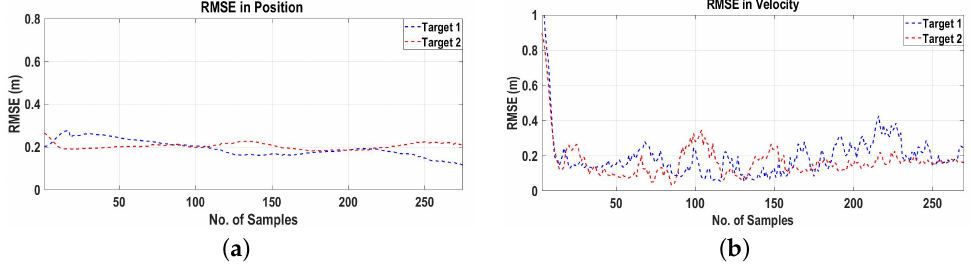
Figure 7. RMSEs in position and velocity for Scenario 1. ( a ) RMSE in position; ( b ) RMSE in